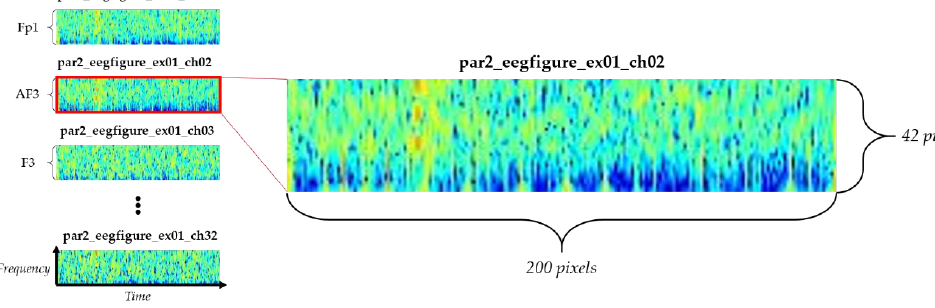
Figure 4. Wavelet transformed spectrogram for each electrode.